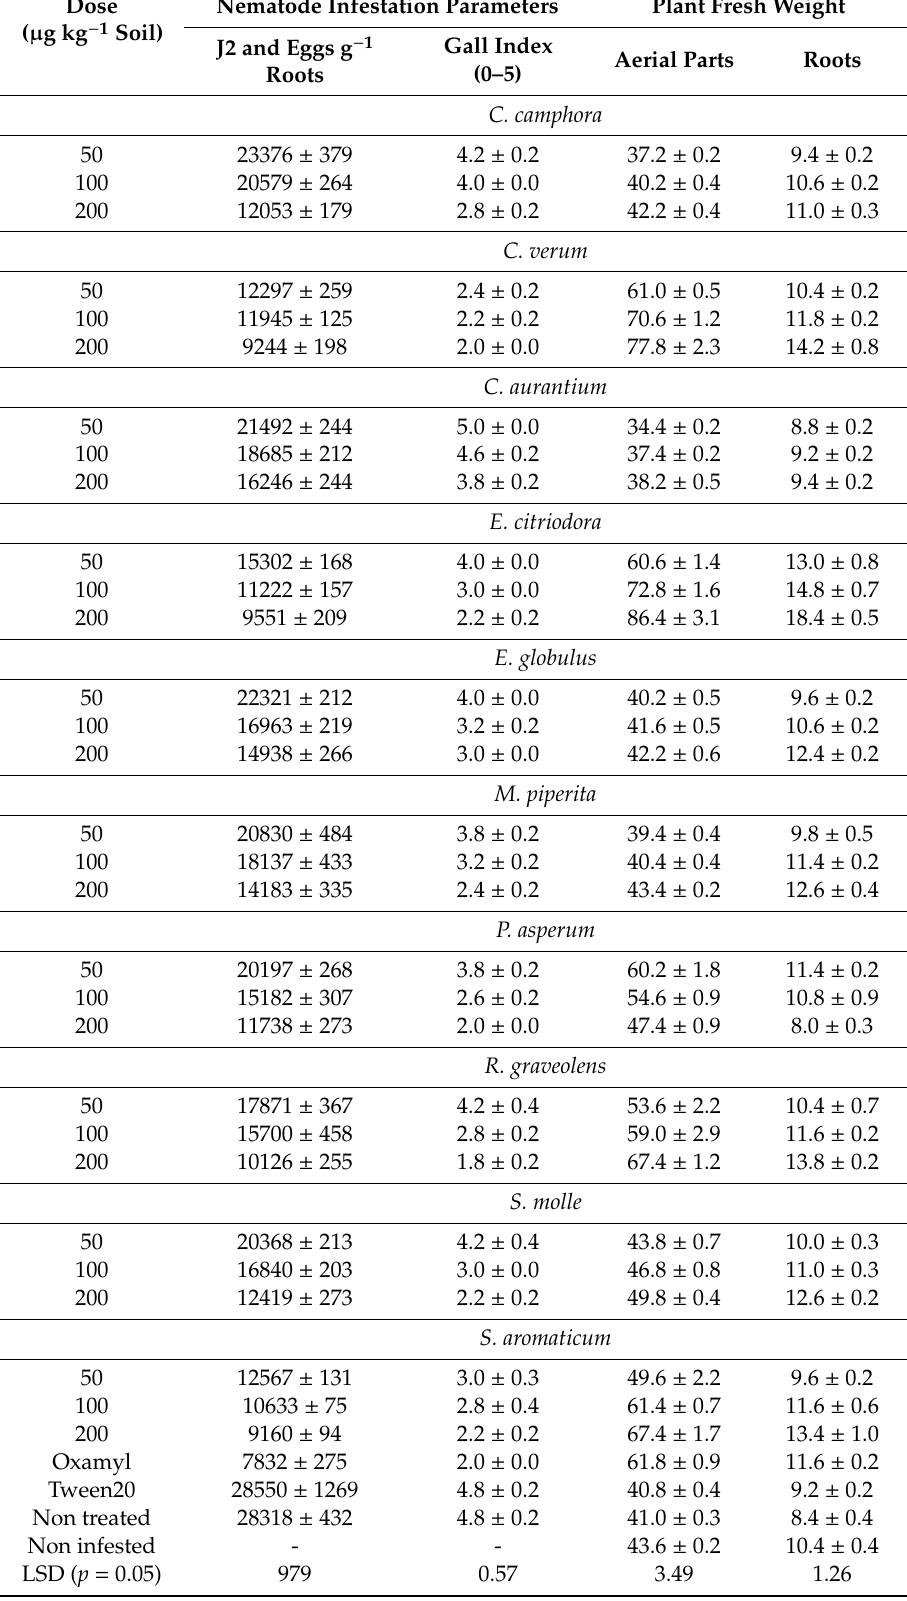
Table 4. E ff ects (means of five replicates ± SE) of soil treatments with di ff erent rates of the ten tested EOs on the infestation of the root-knot nematode M. incognita and the growth of tomato (cv. Roma).